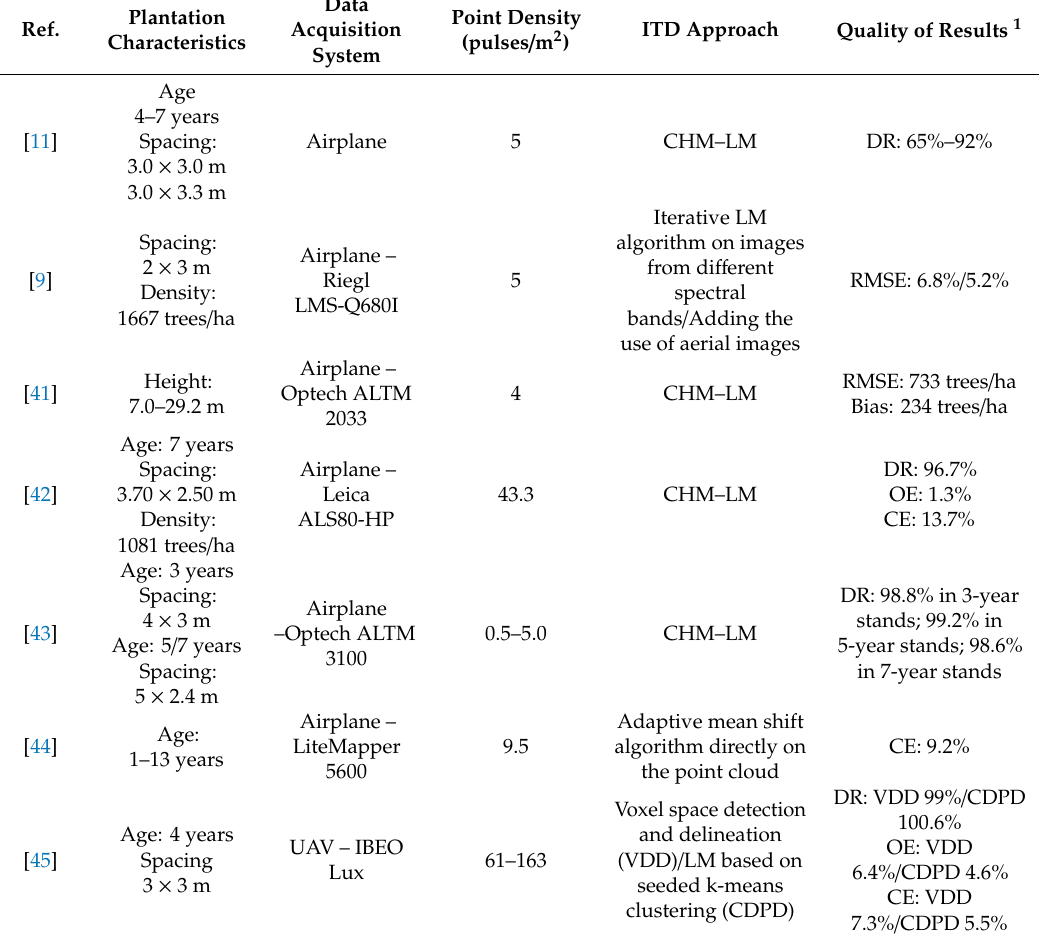
Table 1. Summary of the most significant works on light detection and ranging (LiDAR)-based individual tree detection (ITD) of Eucalyptus . Canopy height model local maxima (CHM–LM).